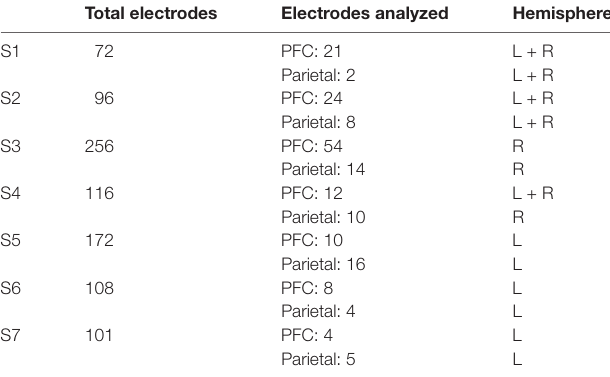
TABLE 1 | Individual electrode